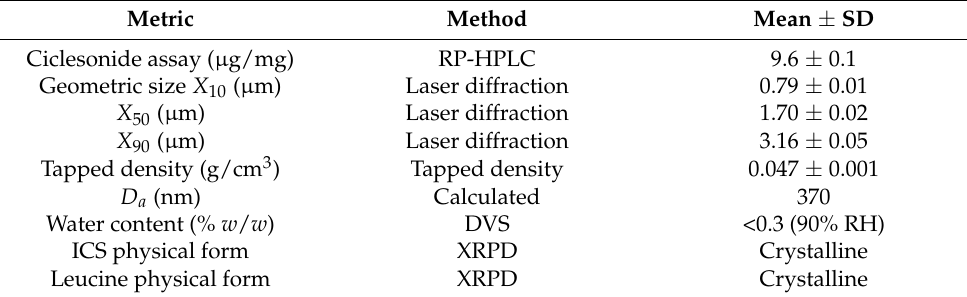
Table 1. Properties of ciclesonide powder for inhalation. Metric Method Mean ± SD Ciclesonide assay ( µ